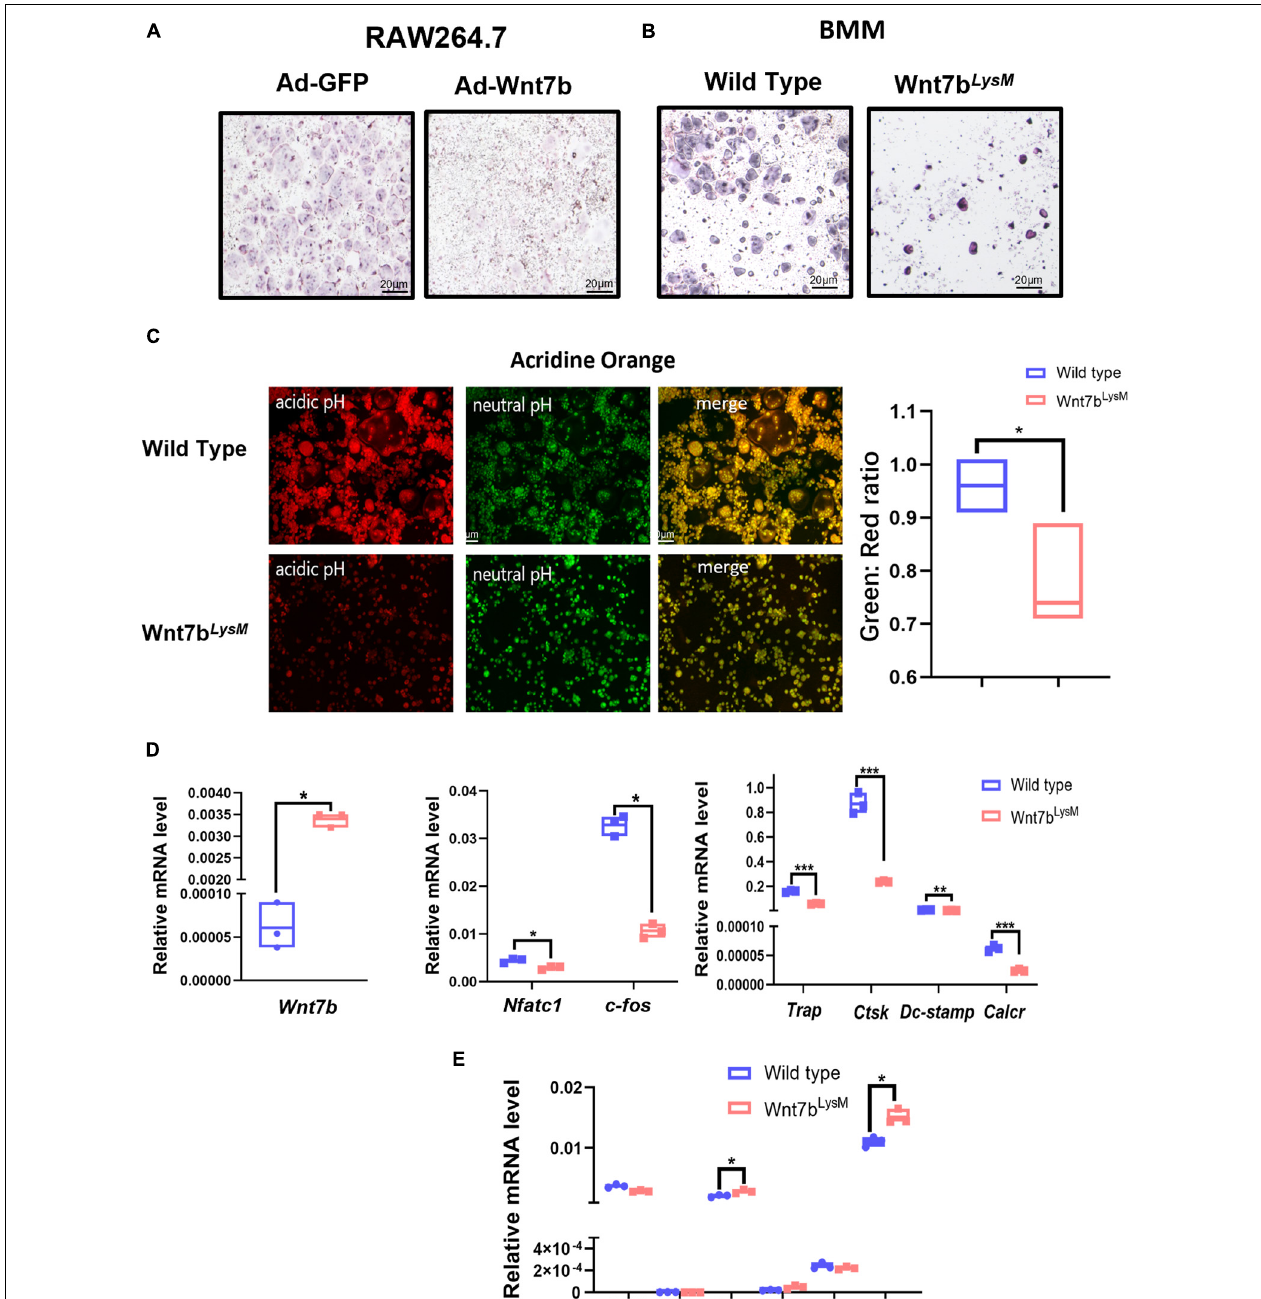
FIGURE 2 | Wnt7b impairs osteoclastogenesis in BMMs. (A) Raw264.7 transfected with adeno-GFP or adeno-Wnt7b and (B) BMMs isolated from WT or Wnt7b LysM mice were induced with M-CSF and RANKL for 5 days. (A,B) TRAP staining was used to identify TRAP-positive multinucleated cells. (C) Acridine orange (AO) staining was applied to access the acidification of RANKL-induced multinucleated cells at day 5. Green represents neutral pH, and red represents acidic pH. Intracellular pH at day 5 is decreased after in the presence of Wnt7b compared to wild type. (D) The expression levels of genes including early osteoclastic differentiation markers and osteoclast functional markers were detected by real-time PCR analysis. (E) Negative regulators in BMMs without RANKL inducement were screened by quantitative PCR. N = 3. * p < 0.05; ** p < 0.01; *** p <